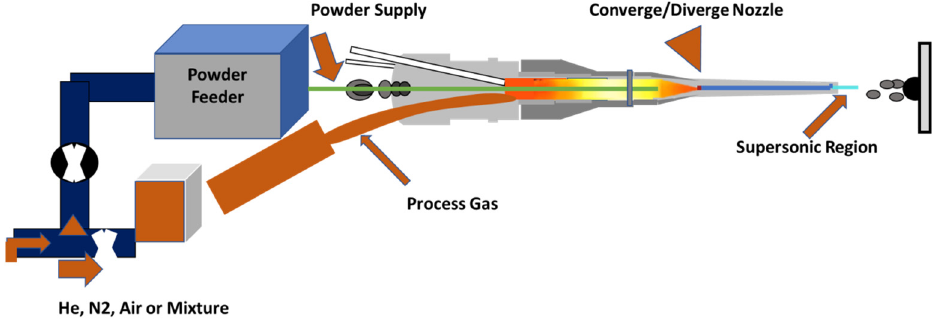
Figure 2. Schematic diagram of a cold spray gun.